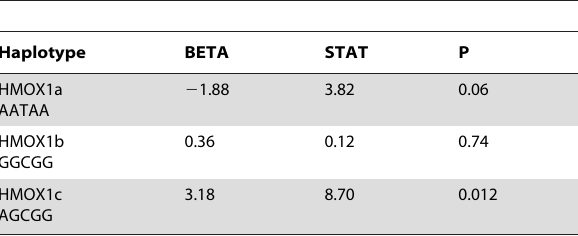
Table 5. Haplotypic quantitative trait analysis of HMOX1 gene expression in cerebral malaria